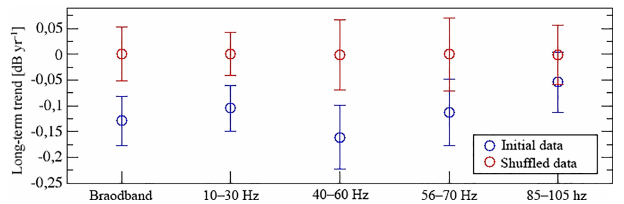
Figure 2. Trend estimation in SPL bands (deseasonalized data) using “delete- d ” jackknife sampling with 1000 subsets with d = 10000 randomly deleted data points. Blue dots show the slope with corresponding jackknife uncertainties of the least-squares linear re- gression, whereas red dots show the trend (the absence of it, with zero slopes of linear regression) for the shuffled data, i.e. the data with randomly allocated values of the time series.